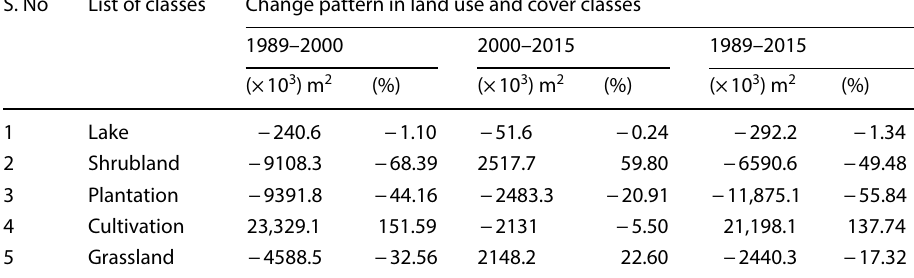
Table 6 Change pattern in land use and cover classes of Hayk Lake